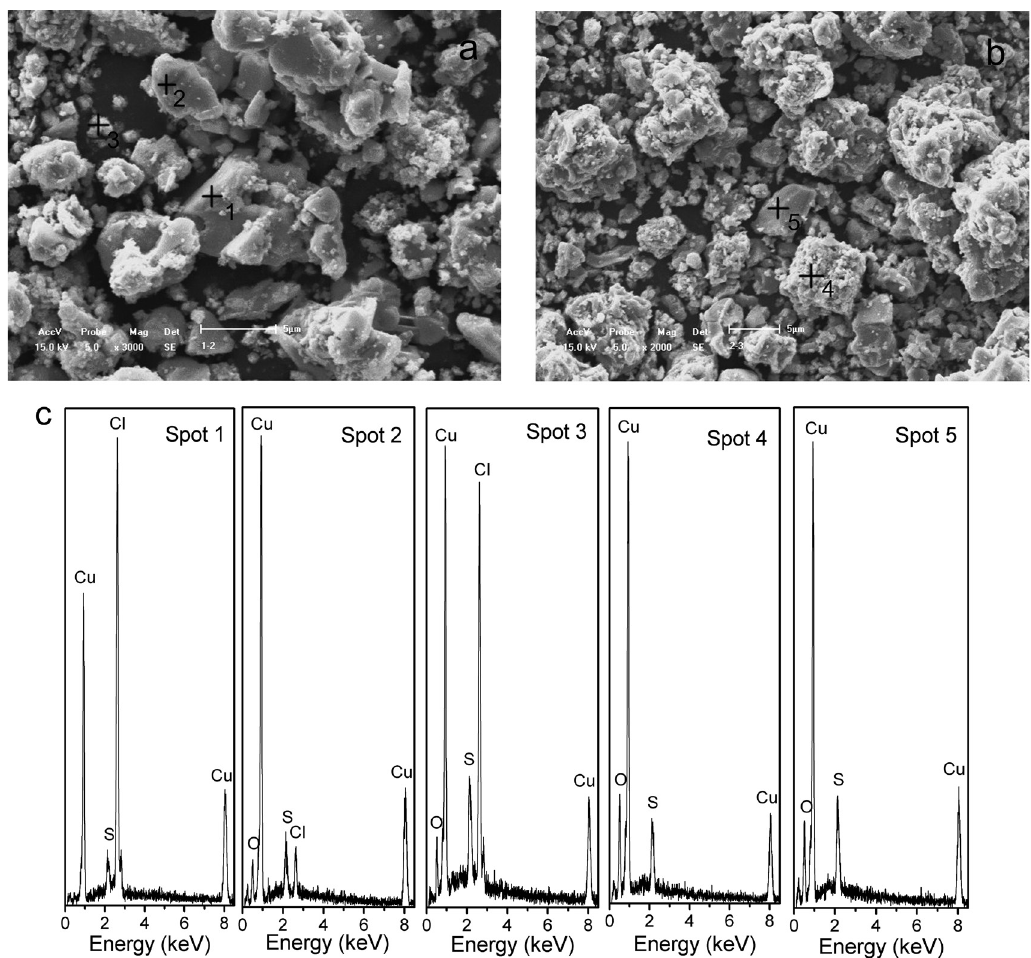
Fig. 10: SEM micrographs and the corresponding EDS patterns of samples before and after microwave roasting. (a) Samples before microwave roasting. (b) Samples after microwave roasting. (c) EDS patterns of spots in (a) and